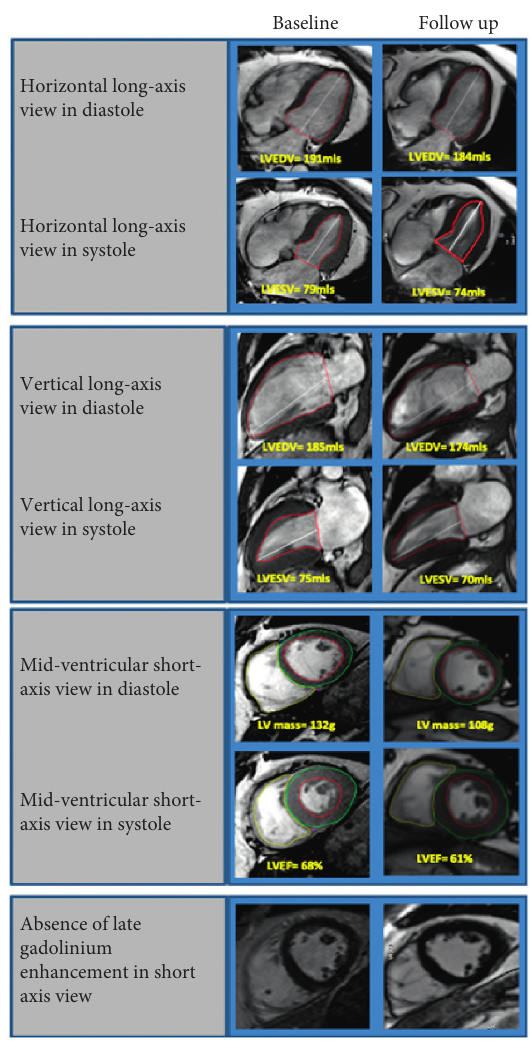
Figure 1: Representative examples of CMR imaging. Represen- tative examples of cine images (horizontal long axis, vertical long axis, and mid-ventricular short axis in diastole and systole) and late gadolinium enhancement imaging (mid-ventricular short axis) in patients with T2D at baseline and